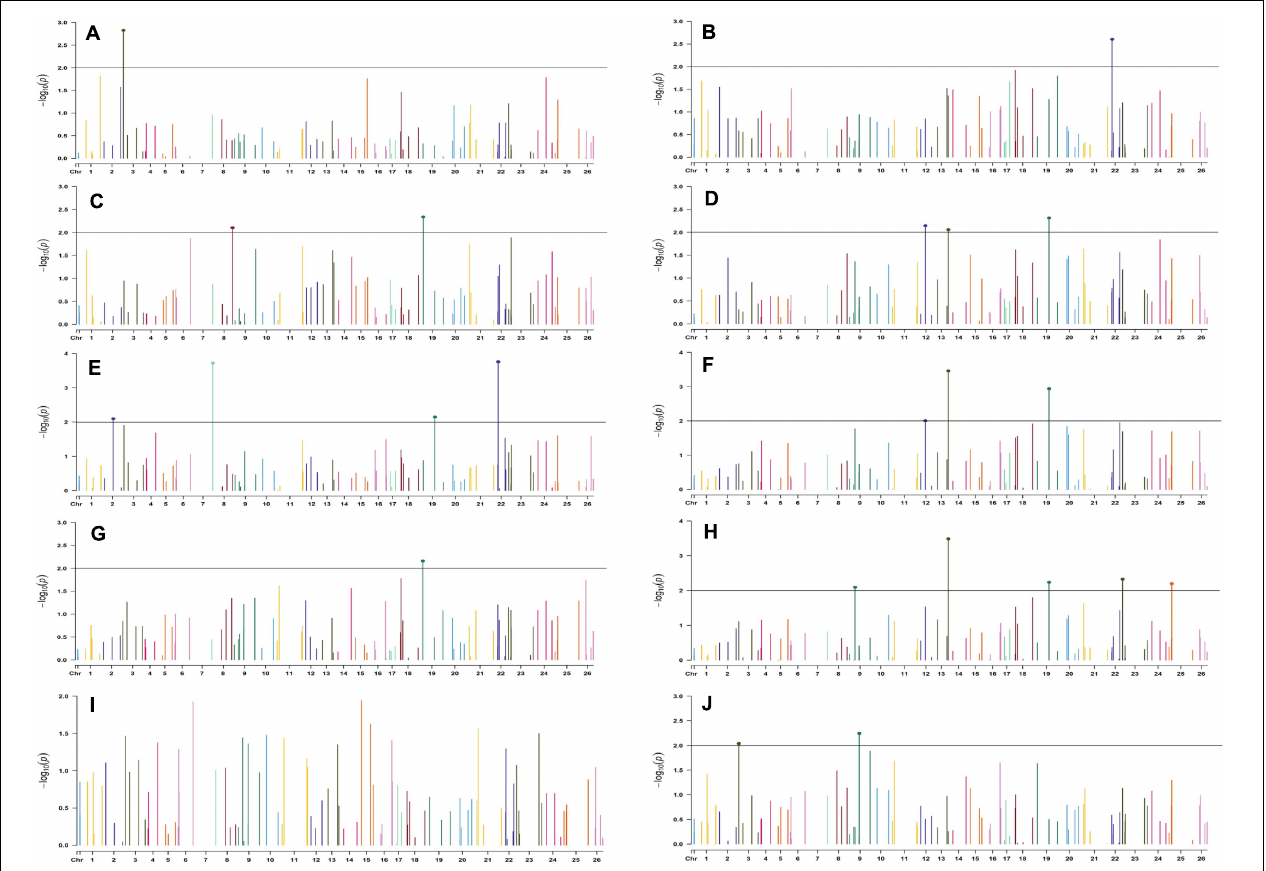
FIGURE 7 | Manhattan plots for the normal sown environment of 2018 for various traits under study by the MLMM model. Significant marker above threshold {at –log10 ( p ) > 2} is highlighted with bold dot head on the marker’s line. (A) Days to first flower, (B) plant height, (C) number of monopods, (D) number of bolls per plant, (E) boll weight, (F) seed cotton yield per plant, (G) ginning out turn, (H) lint yield, (I) seed index, and (J) lint index.